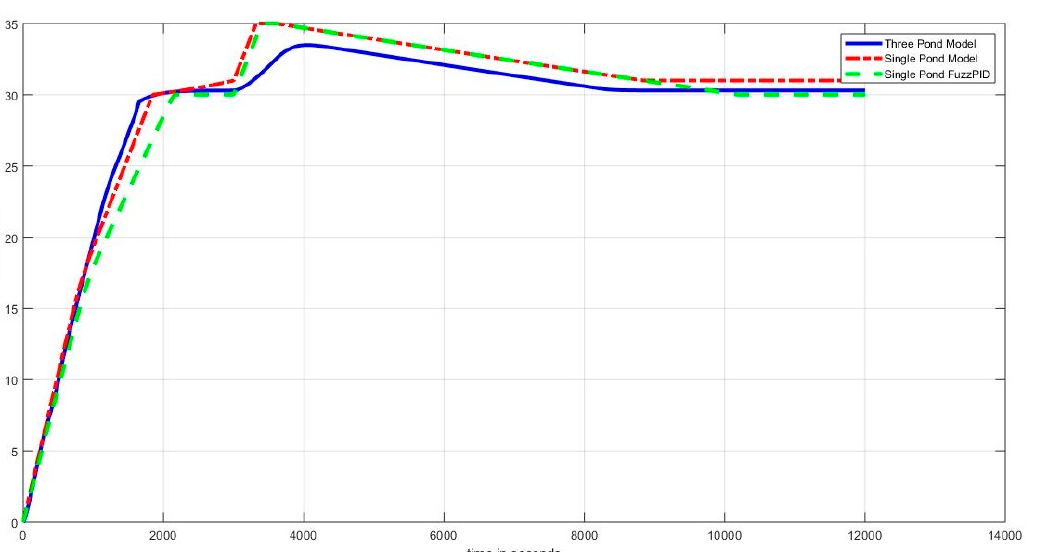
Figure 26. Traditional system (Fuzzy, FuzzyPID) vs. the proposed system (positive surge, steady state).